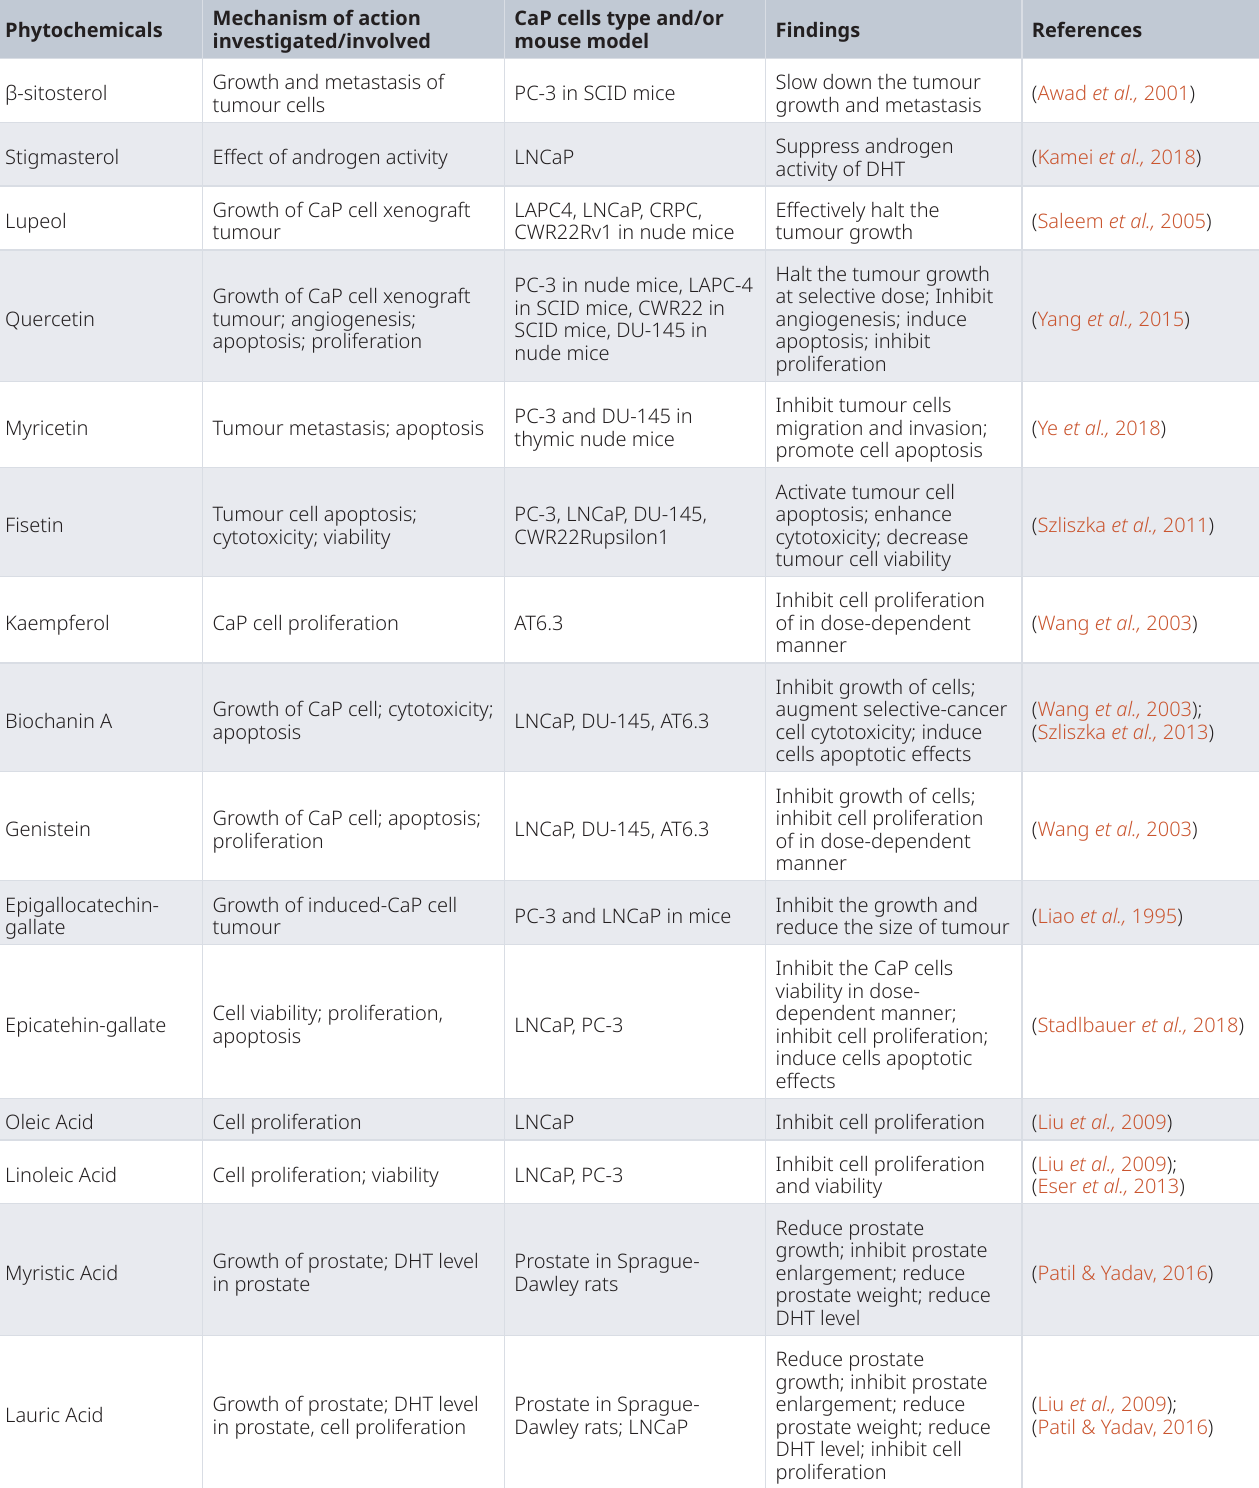
Table 1. Summary of findings from anti-CaP studies of various